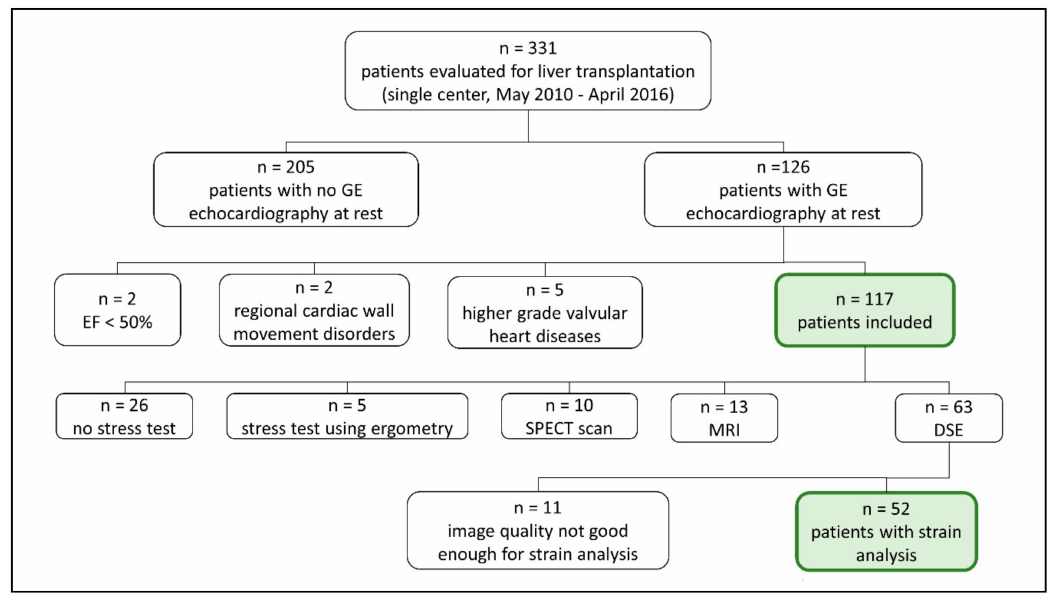
Figure 1. Overview of the inclusion and exclusion